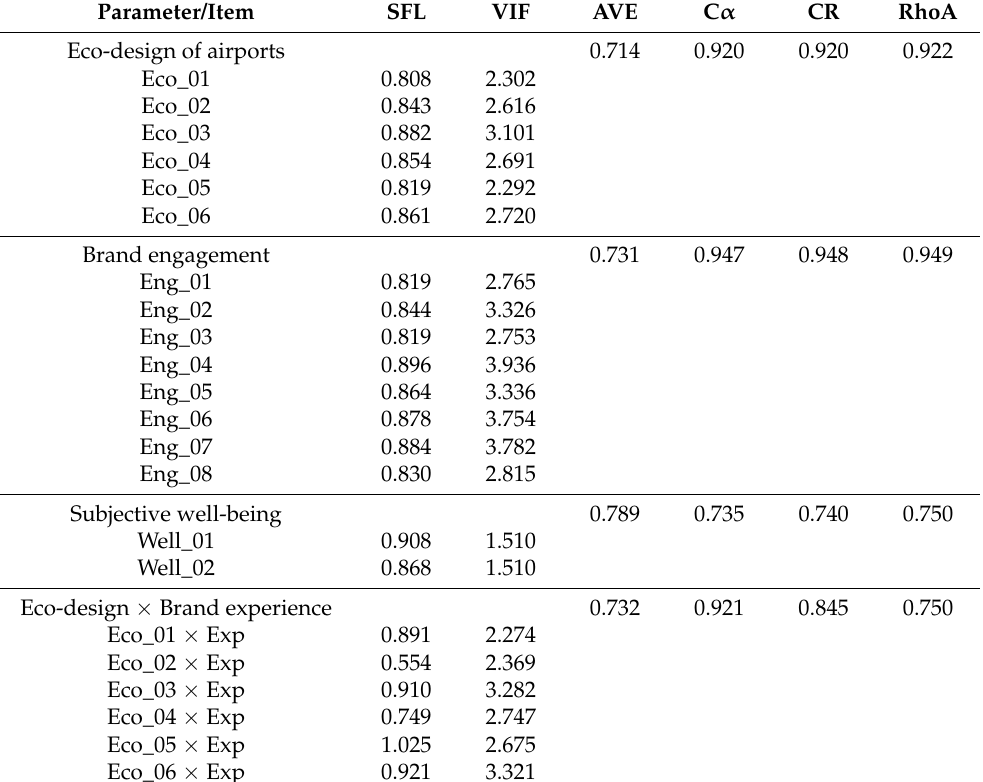
Table 2. Outcomes of the convergent validity.